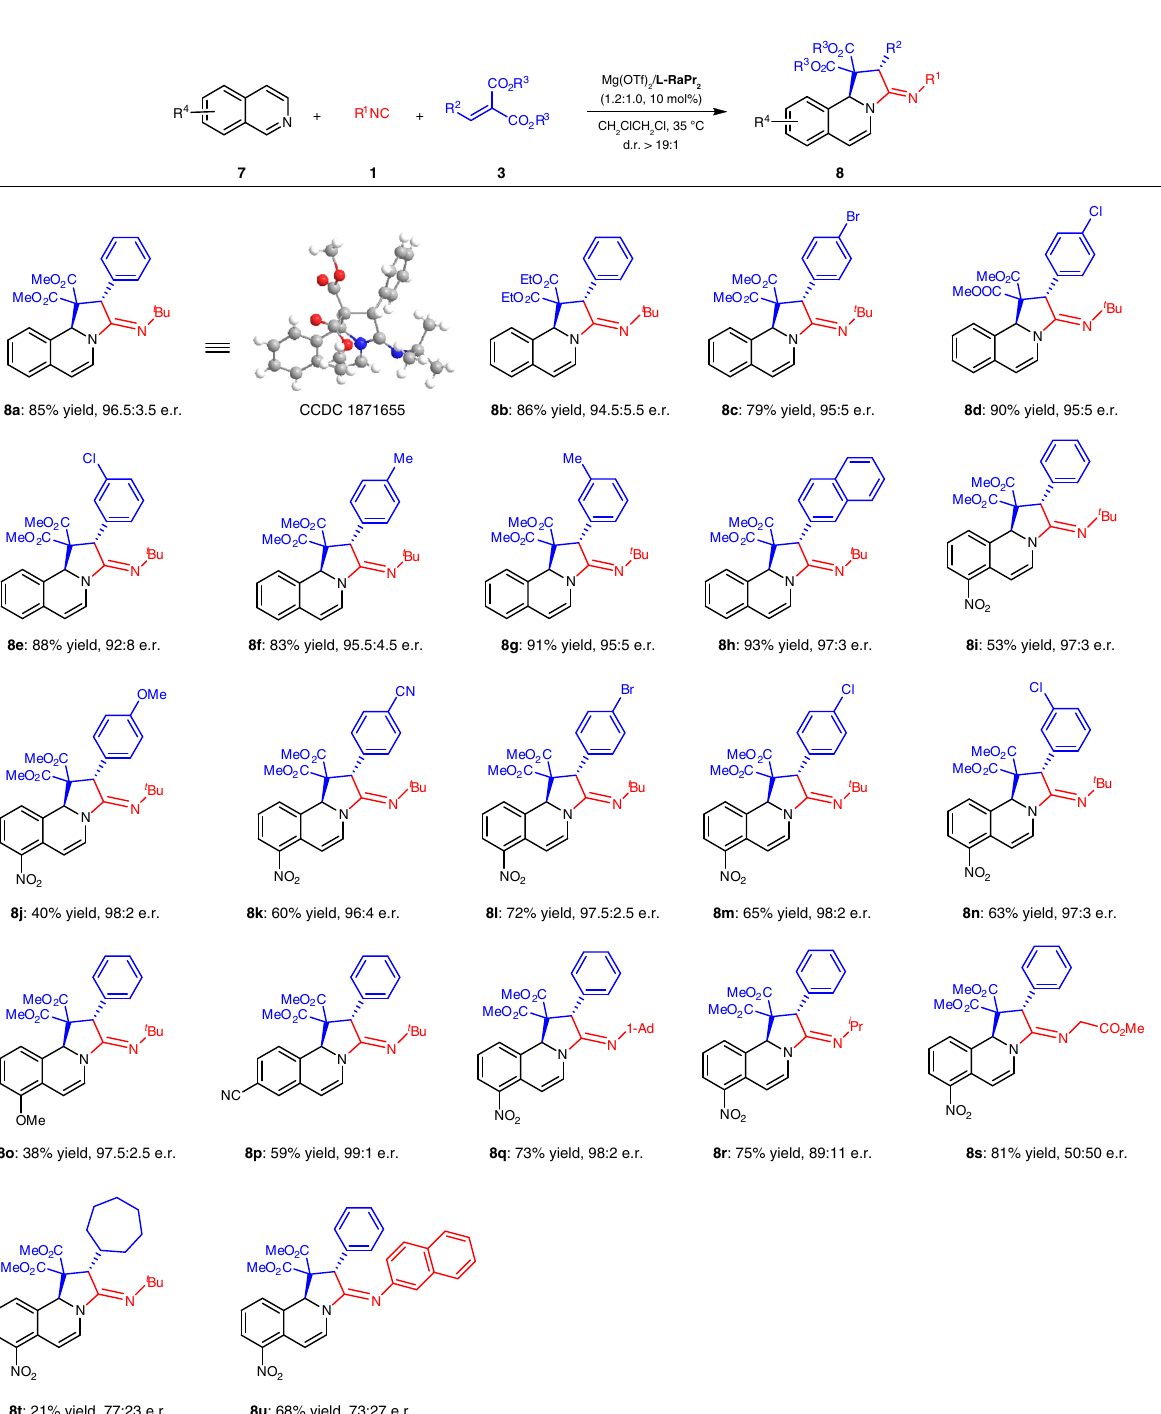
Fig. 4 Substrate scope of asymmetric synthesis 1,2-dihydroisoquinoline derivatives. All reactions were carried out 7 (0.10 mmol), 1 (0.15 mmol), 3 (0.15 mmol), and Mg(OTf) 2 / L-RaPr 2 (1.2:1.0, 10 mol%) in CH 2 ClCH 2 Cl (0.5 mL) at 35 °C for 2 days. Isolated yield and e.r. was determined by CSP-HPLC